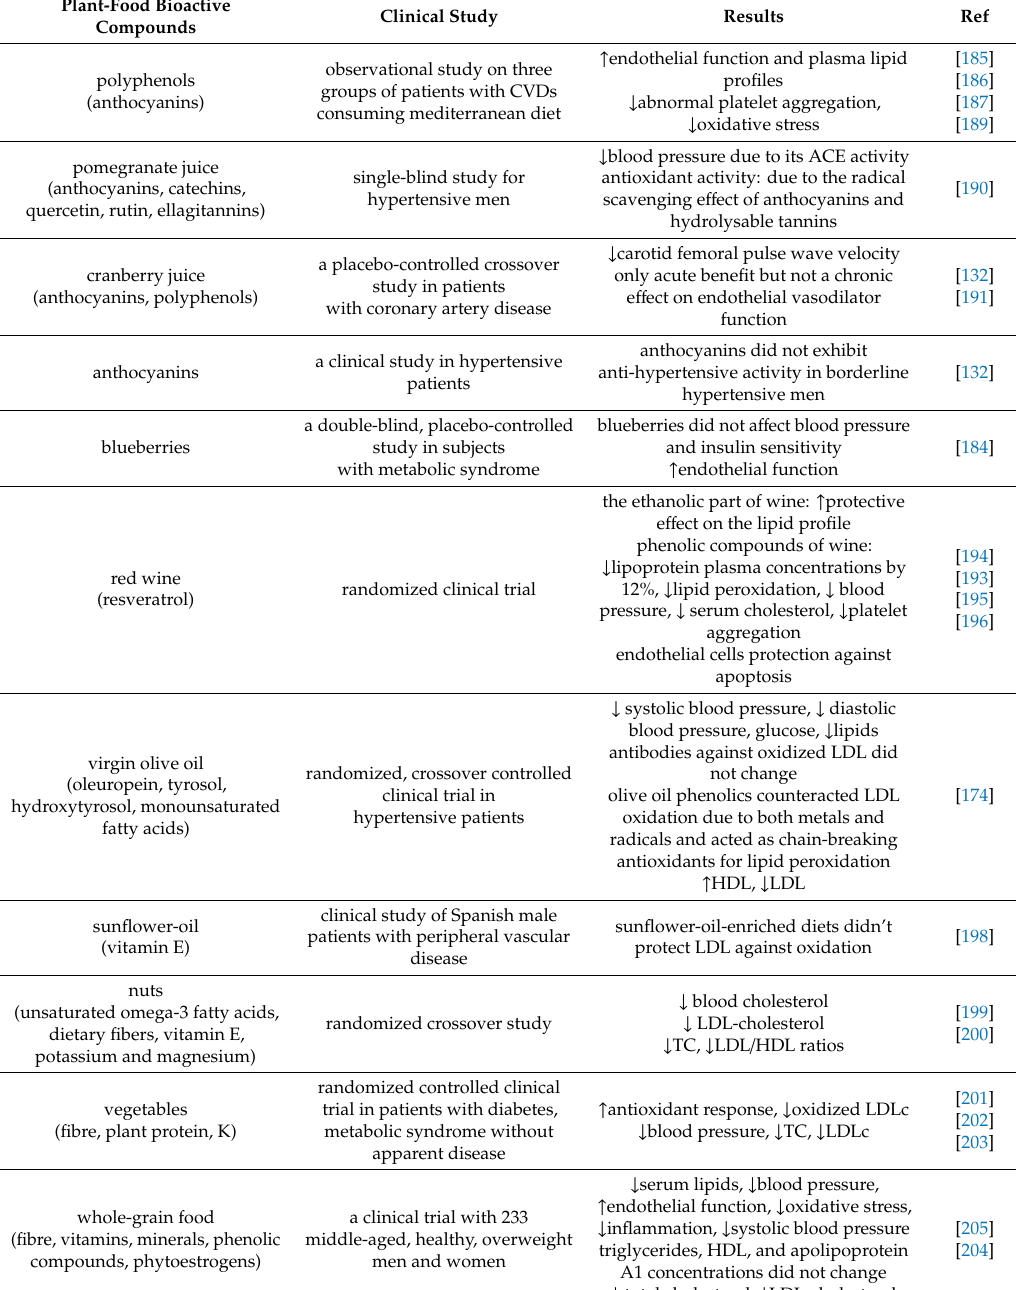
Table 3. Clinical Studies Related to Cardioprotective E ff ects of Plant-food Bioactive Compounds. Plant-Food Bioactive